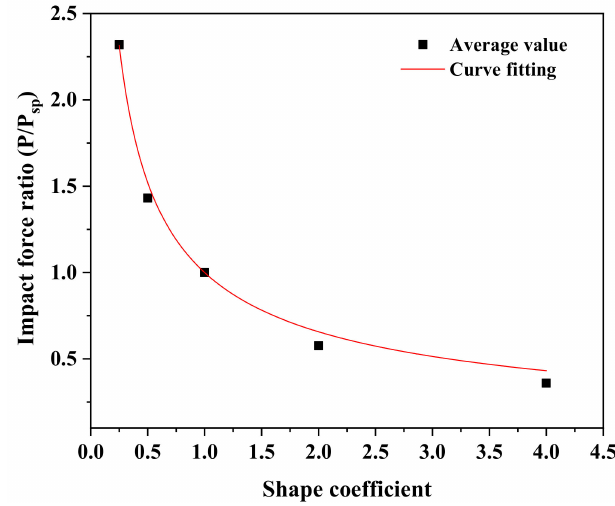
Figure 5. Second fitting results.